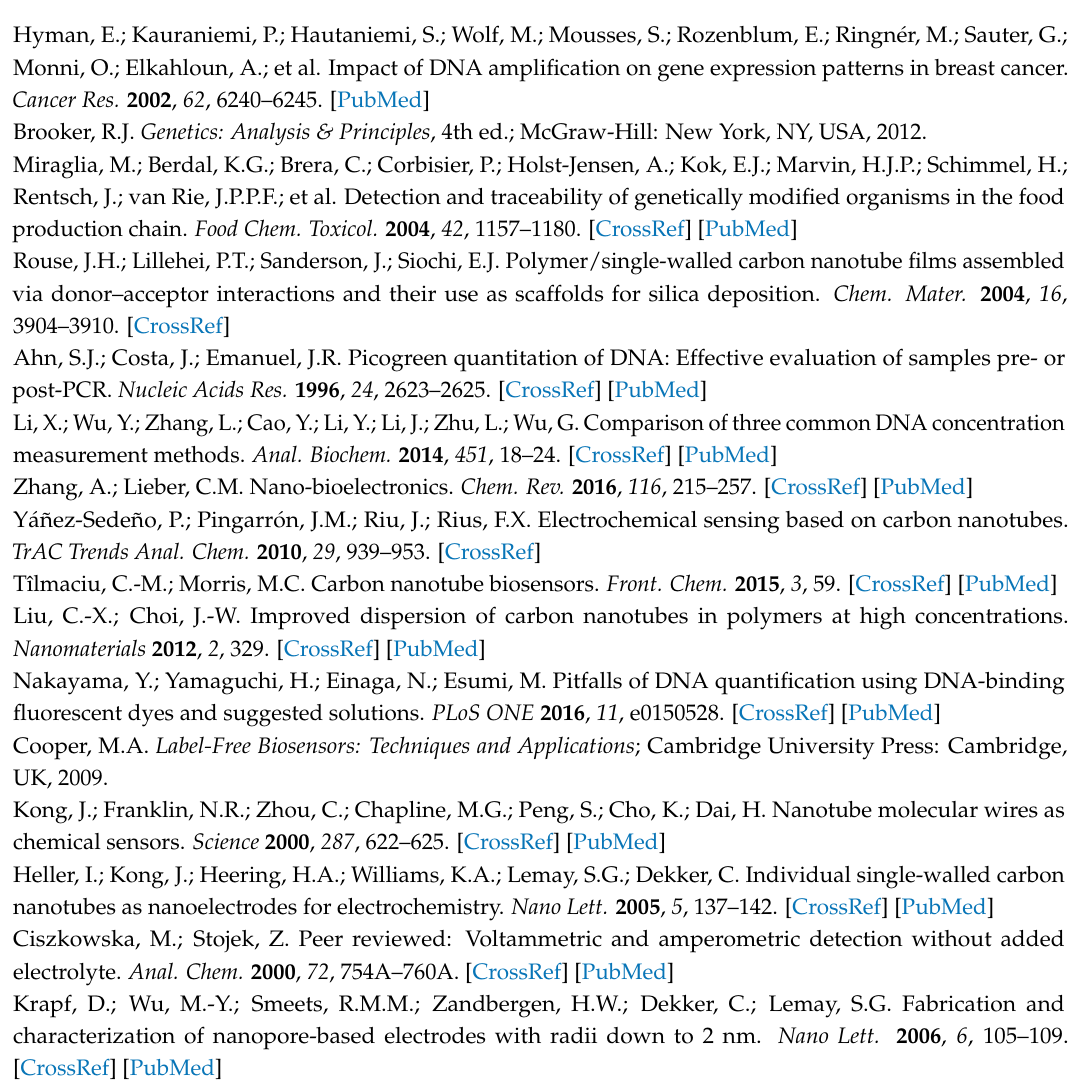
Figure S1: FT-IR spectrum for PEI/SWCNTs coated microneedle, SWCNTs in DMF, and 1% PEI. Results indicate the presence of the coating layers on the microneedle’s surface, Figure S2: Thickness and surface roughness of (a) PEI coated and (b) PEI/SWCNTs coated